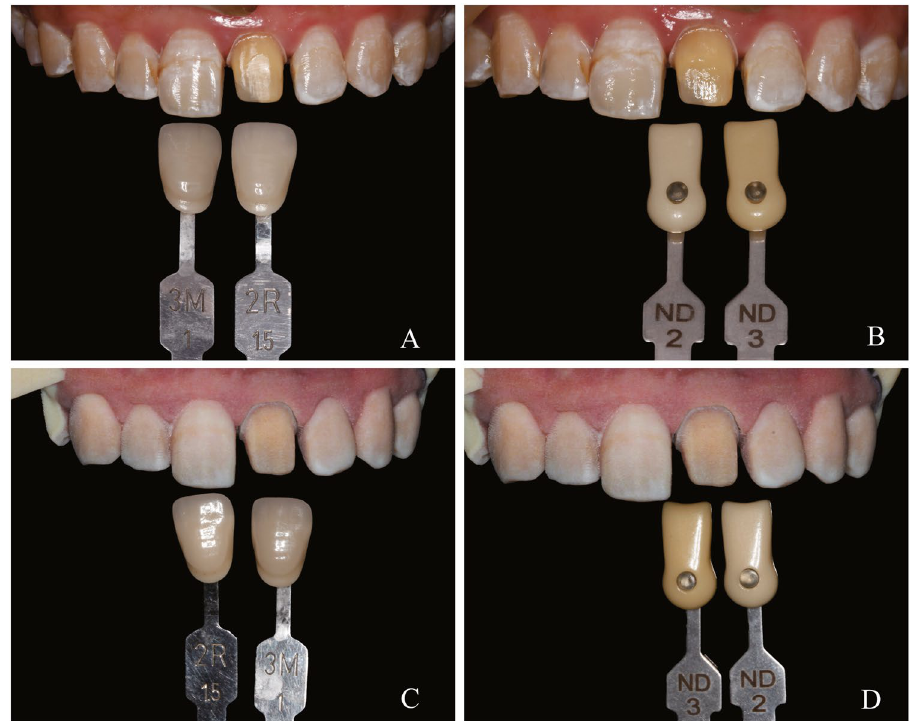
Figure 8. A preliminary clinical application of 3D printed chromatic model. A and B, intraoral view. C and D, printed model. The shade tabs were used to record the actual tooth shade and the model was used